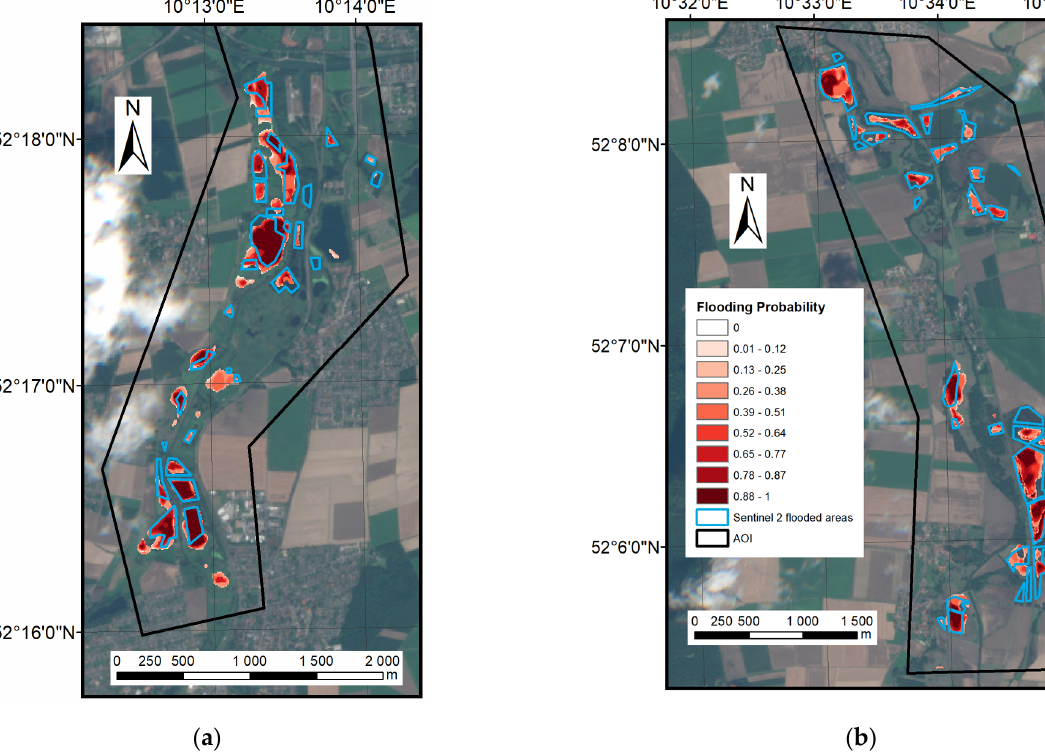
Figure 7. Flood extent detected by the developed solution (in red) from Sentinel-1 images acquired on July 29 and on 1 August, 2017. Manually digitized flood extent (in blue) from Sentinel-2 imagery acquired on 31 July 2017. ( a ) The southern part of sub-area 1 and ( b ) sub-area 7 in Germany, 2017. Table 1. Statistical evaluation of comparison between flood extent detected by the developed solution and digitized from Sentinel-2 imagery for the Germany 2017 event. OA—overall accuracy, PA—producer accuracy, UA—user